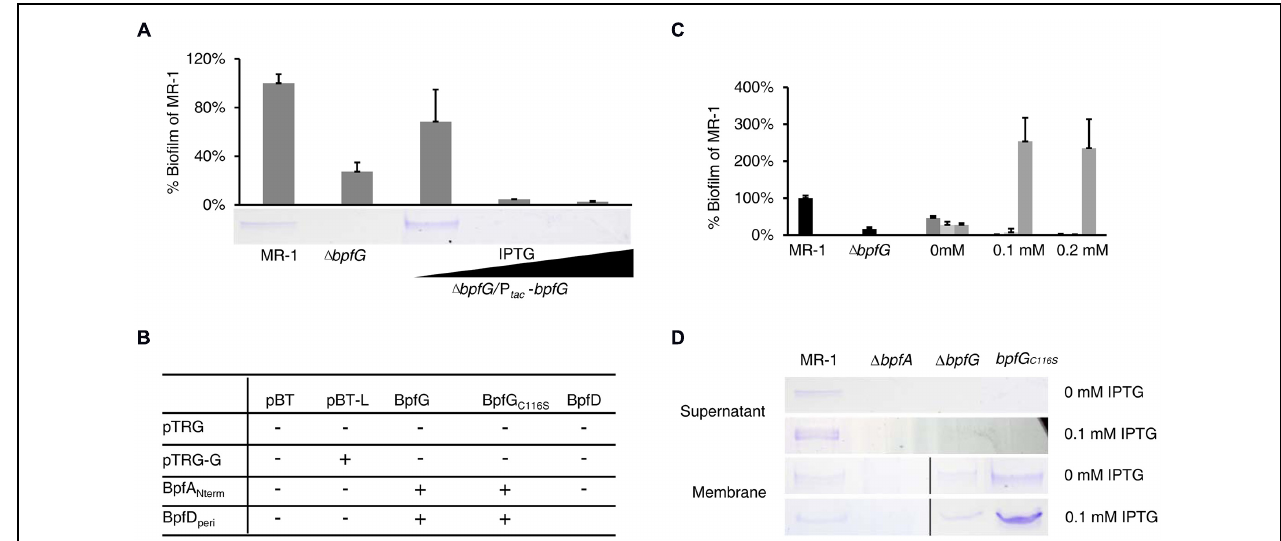
FIGURE 3 | BpfG is a periplasmic cysteine proteinase required for BpfA export and cleavage. (A) The biphasic impact of BpfG on biofilm. (cid:2) bpfG mutant was complemented with a plasmid carrying a P tac - bpfG construct, treated with different concentrations of IPTG (the black triangle underneath indicates the increase of IPTG level. 0, 0.1 mM, 0.2 mM from left to right, same in all figures unless specified otherwise). Error bar represents SE of three experiments. BpfA in the supernatant fraction were shown by protein electrophoresis. Arrow indicates the BpfA protein band. (B) Bacterial two-hybrid assay results of indicated proteins. “ + ” indicates positive results while “–” indicates that no interaction was detected in this assay. BpfA Nterm is the N terminus ( ∼ 200 a.a.) of BpfA, and BpfD peri is the periplasmic